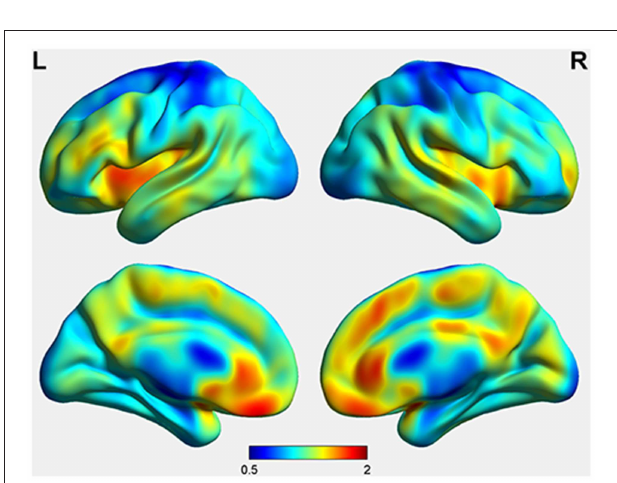
FIGURE 4 | Spatial Distribution of Cerebral Blood Flow of Pediatric Moyamoya Disease Patients. Values were standardized by dividing cerebellar CBF for each individual and then collectively